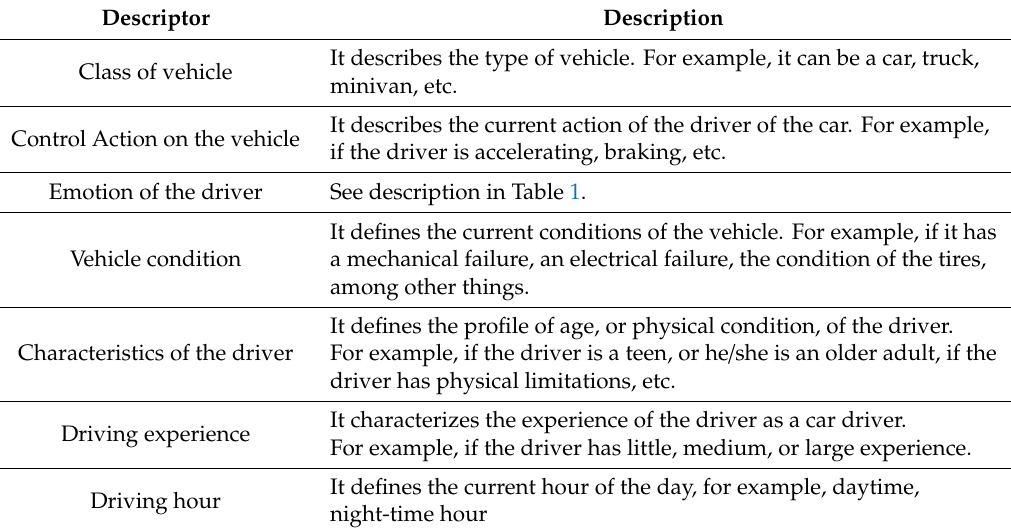
Table 2. Descriptors of the pattern of the driving